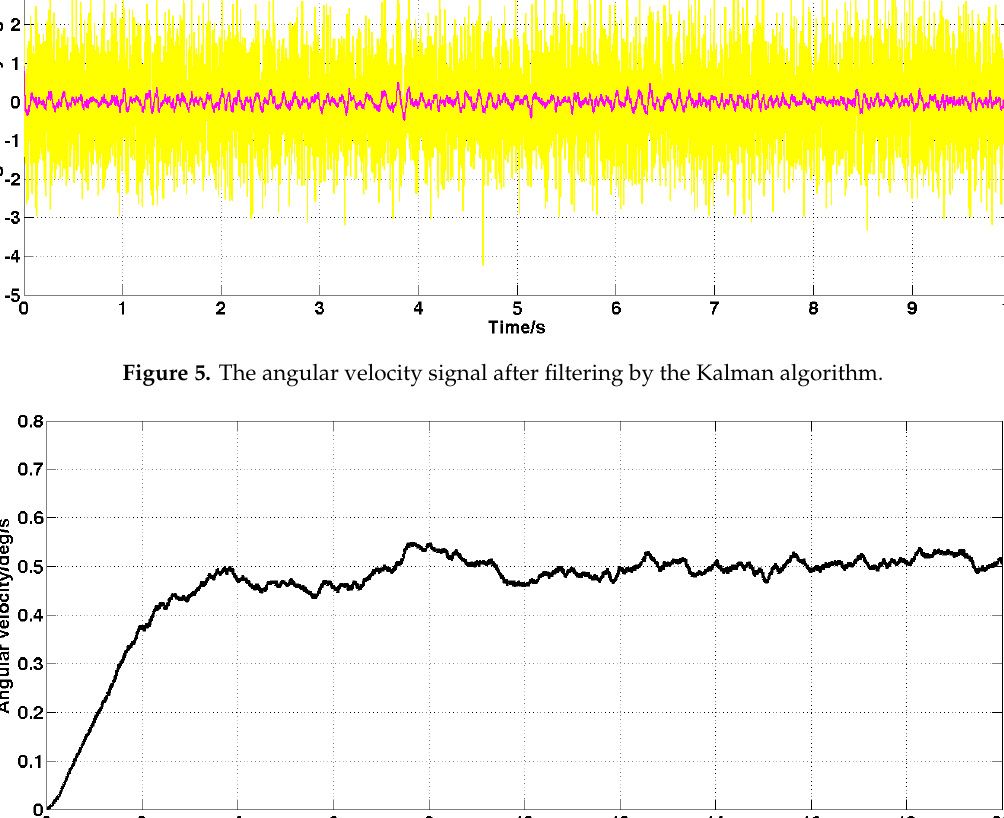
Figure 6. Estimation of gyroscope drift.